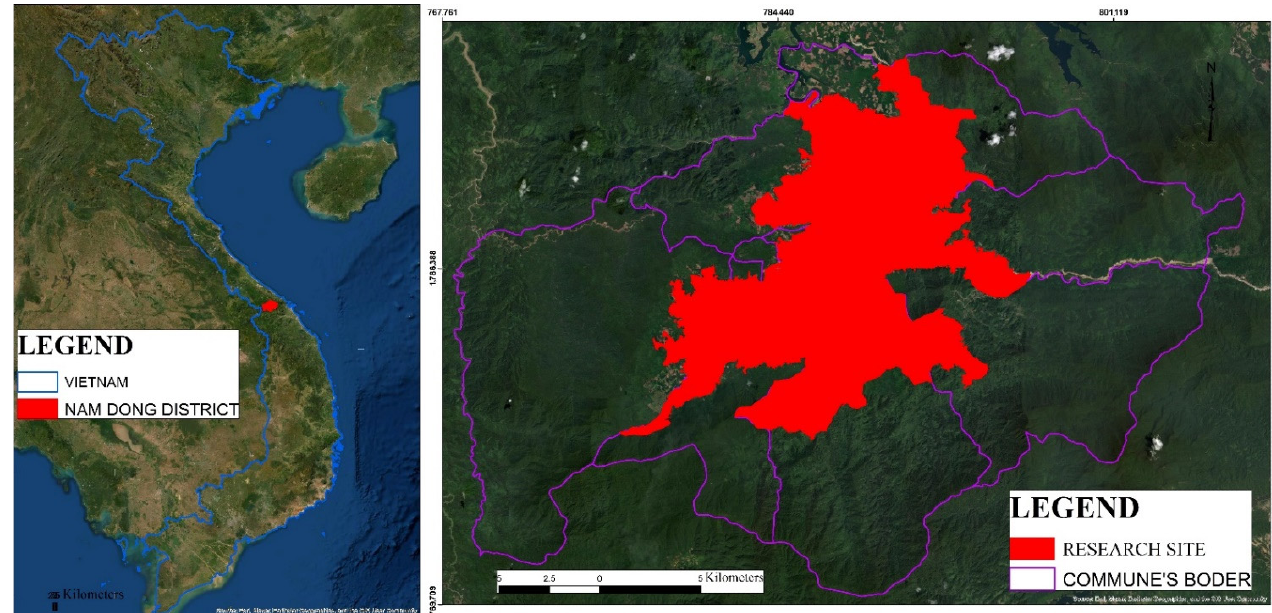
Figure 1. The location of Nam Dong district in Vietnam, including the research site.